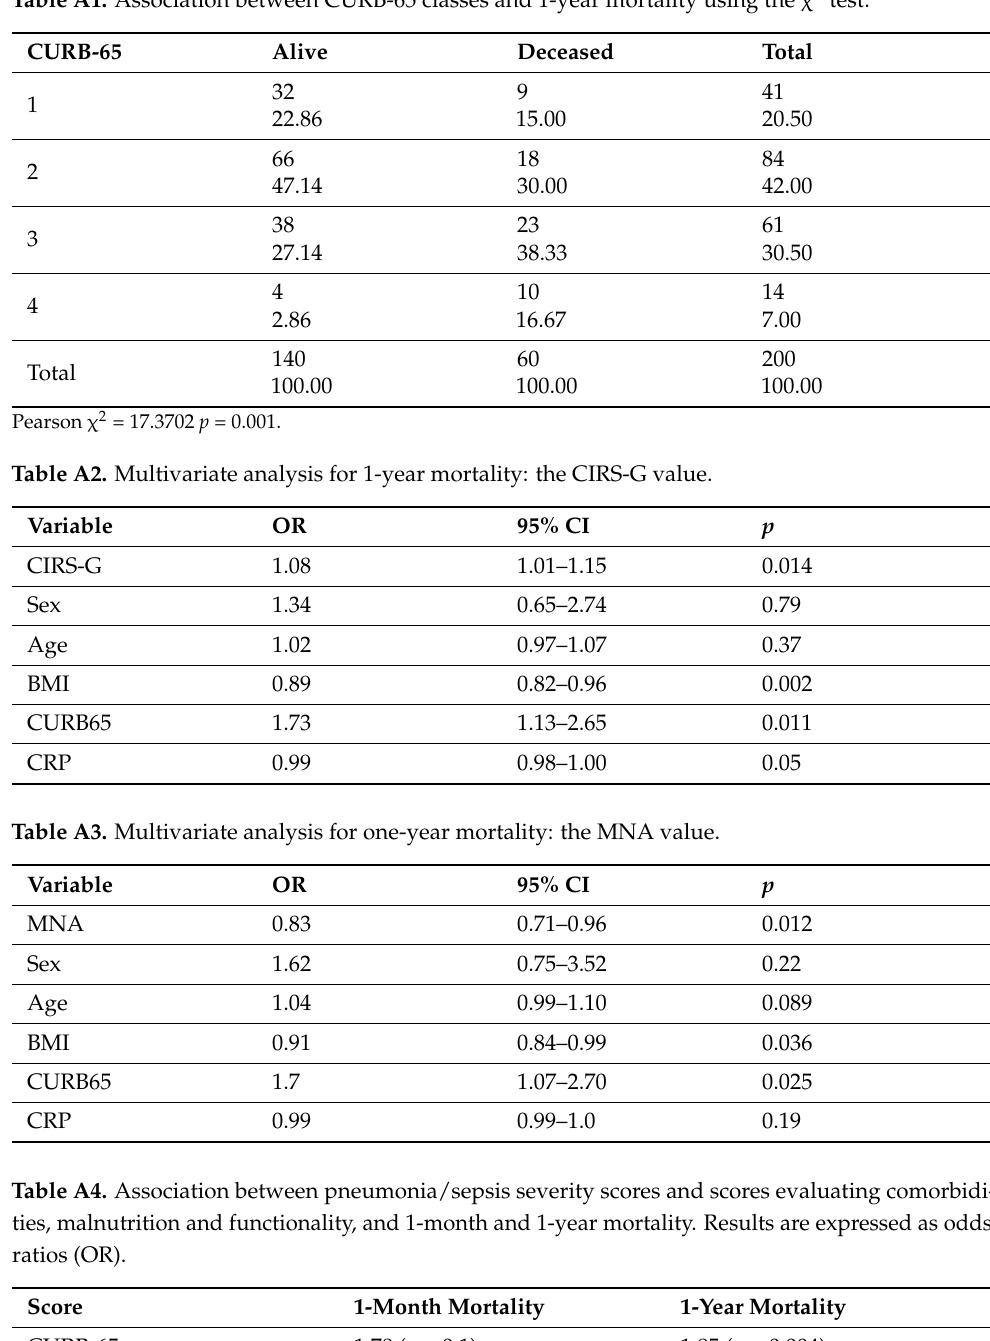
Table A1. Association between CURB-65 classes and 1-year mortality using the χ 2 test.